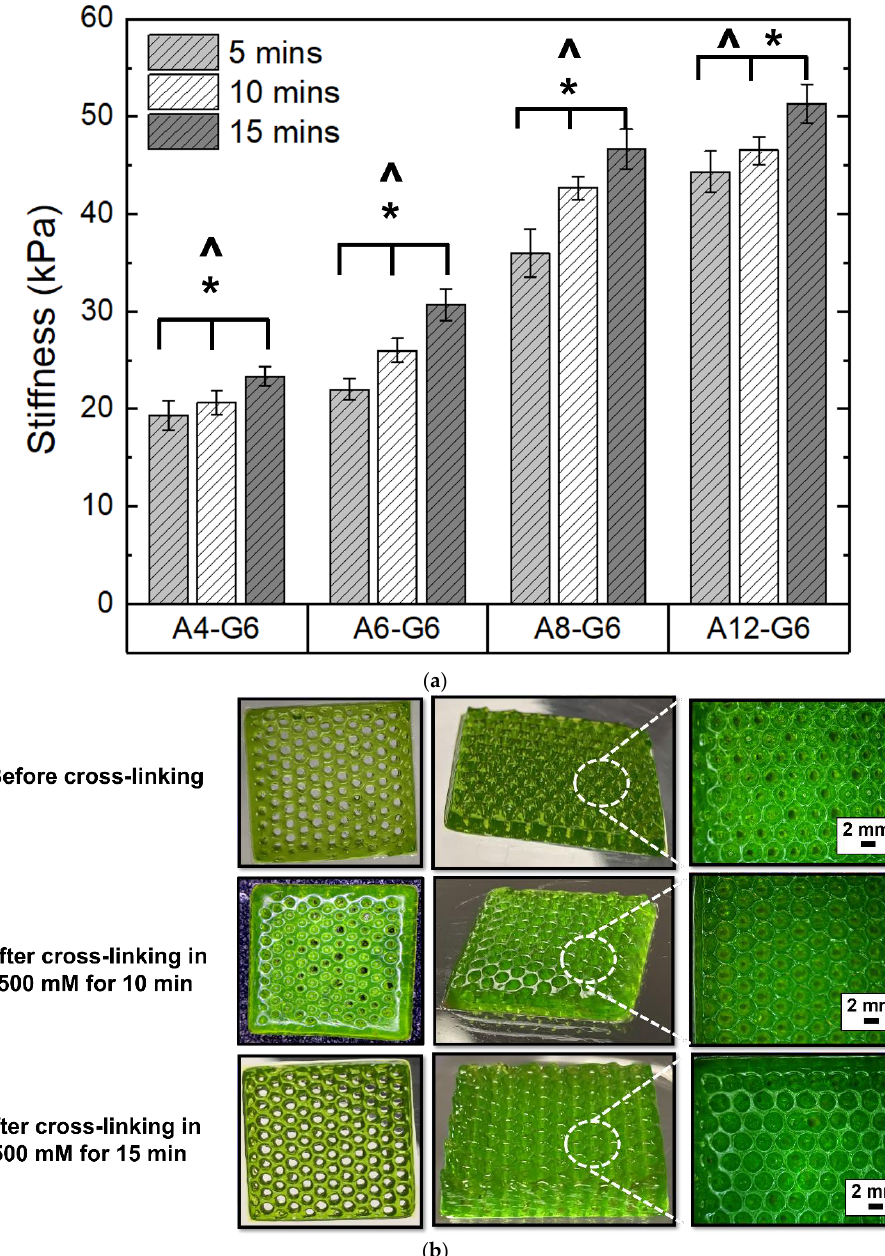
Figure 6. Effect of crosslinking time on the stiffness of the bioprinted scaffolds. ( a ) Structural fidelity and stiffness of the constructs when crosslinked with 500 mM CaCl 2 for 5, 10, or 15 min. * indicates that at 0.05 level (two-way ANOVA), the mean stiffness of the scaffolds crosslinked with varying crosslinking times is significantly different. ^ indicates that at the 0.05 level (two-way ANOVA), the mean stiffness of the scaffolds with varying alginate concentrations is significantly different. ( b ) Digital images of the scaffolds (20 × 20 × 1 mm 3 ) indicate the effect of different crosslinking times on the printed scaffolds.